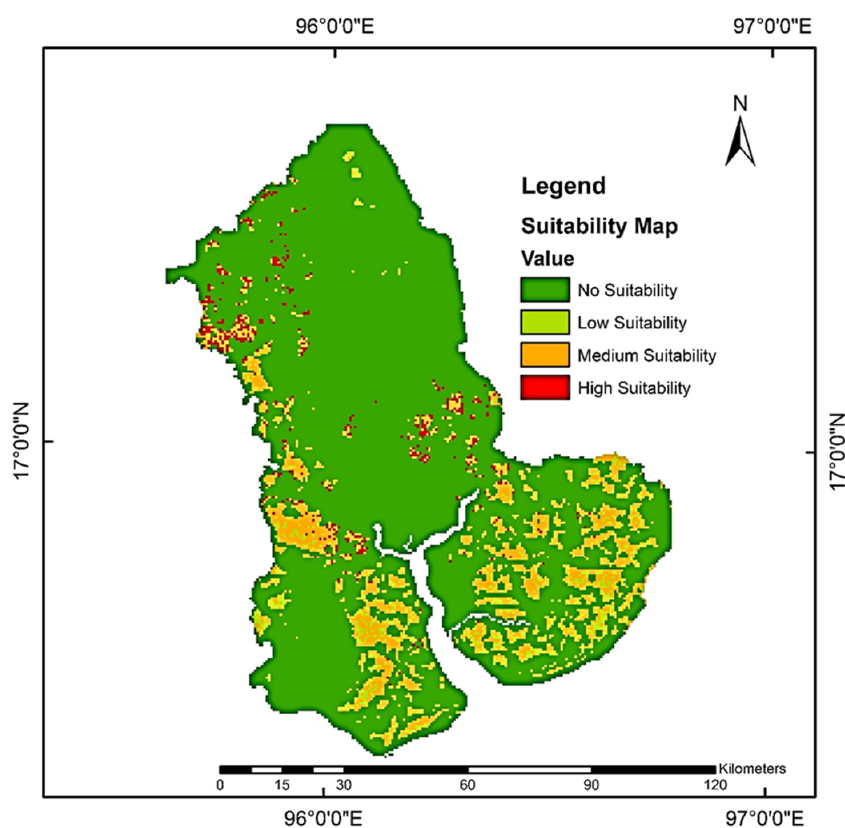
Figure 9. Final Suitability Map for Treatment Facilities.